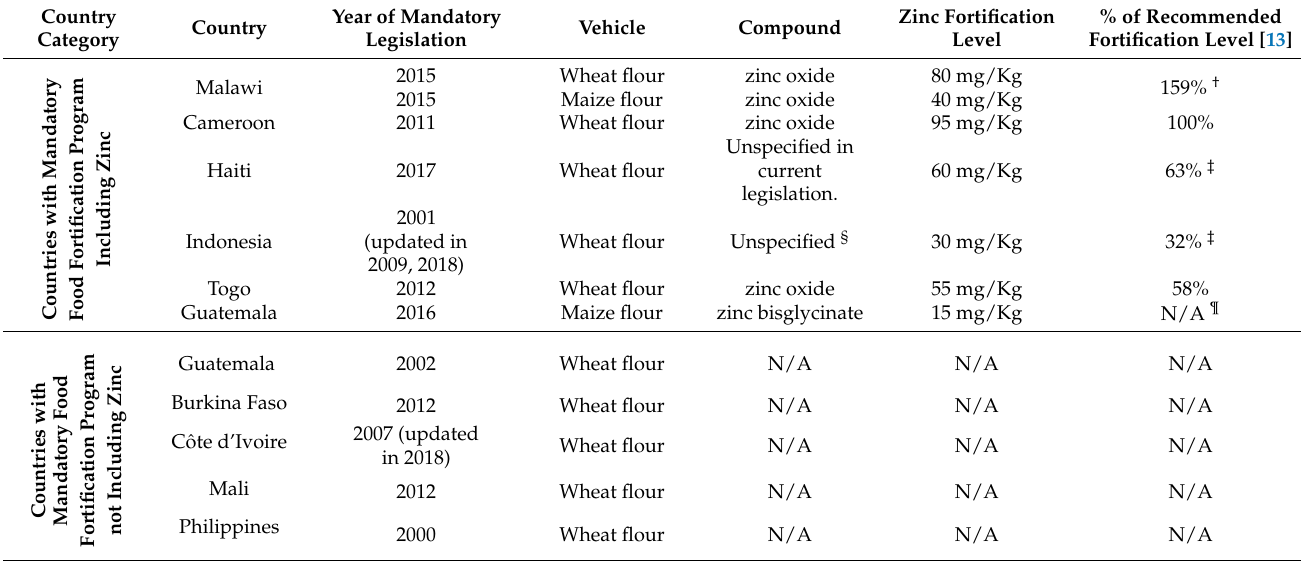
† calculated for the two vehicles in combination using WHO recommendations for zinc addition levels. Food and Agriculture Organization (FAO) estimated per capita flour availability for 2013 was used for the calculation. ‡ Assuming that zinc oxide is used by all producers. § The zinc compound is unspecified in the 2009 mandatory standard in force but the 2018 standard, not yet gazetted, specifies zinc oxide as the compound. ¶ There is no WHO recommendation for this zinc compound. N/A: